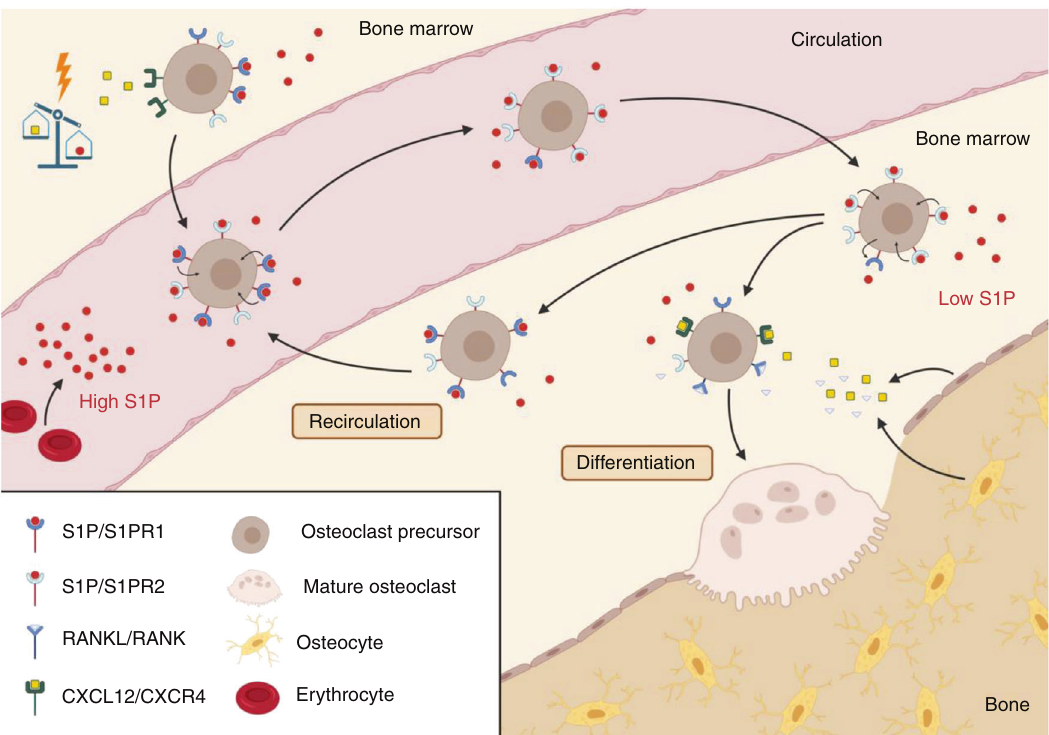
Fig. 2 The role of sphingosine-1-phosphate in the recruitment of osteoclast precursors to resorption sites. Under stress conditions, the equilibrium between C-X-C motif chemokine 12 (CXCL12) and sphingosine-1-phosphate (S1P) is shifted in favor of S1P, leading to S1P receptor 1 (S1PR1)-driven chemoattraction of osteoclast precursors toward high S1P levels in the circulation. In a high S1P environment, S1PR1 is internalized, and S1PR2 becomes predominant. Consequently, osteoclast precursors migrate back to the bone marrow through S1PR2-driven chemorepulsion. Activation of S1PR2 decreases S1PR2 expression and increases S1PR1 expression on the cell surface, allowing recirculation into the bloodstream. To prevent recirculation, osteocytes secrete receptor activator of nuclear factor kappa- Β ligand (RANKL) and